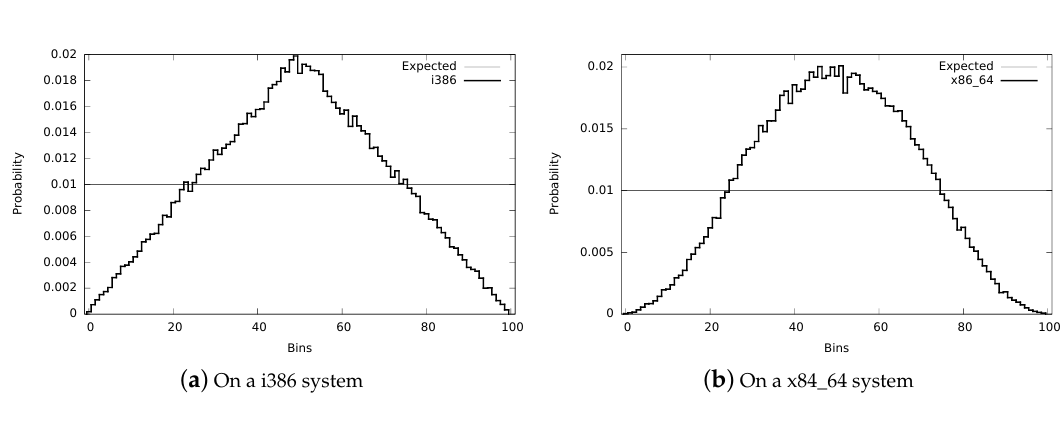
Figure 14. Statistical distribution of mmapped (libraries, thread stacks, anonymous maps, etc.) objects using PaX security